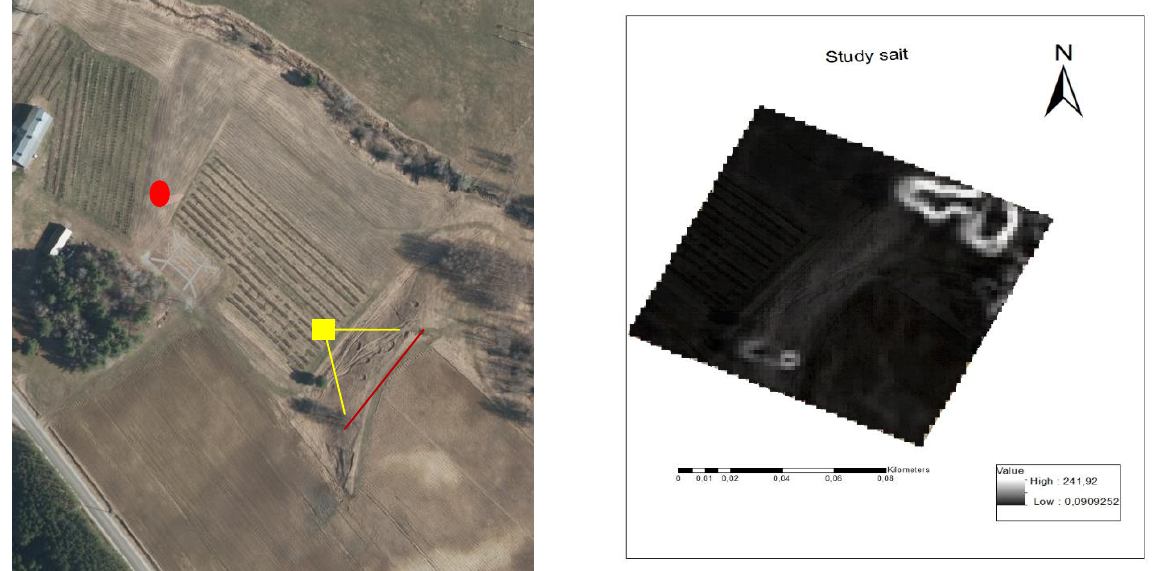
Figure 1, Show aerial photography (left figure) of the study area and the position of locations of Camera and station meteorology that provided data. The right figure is DEM image of study